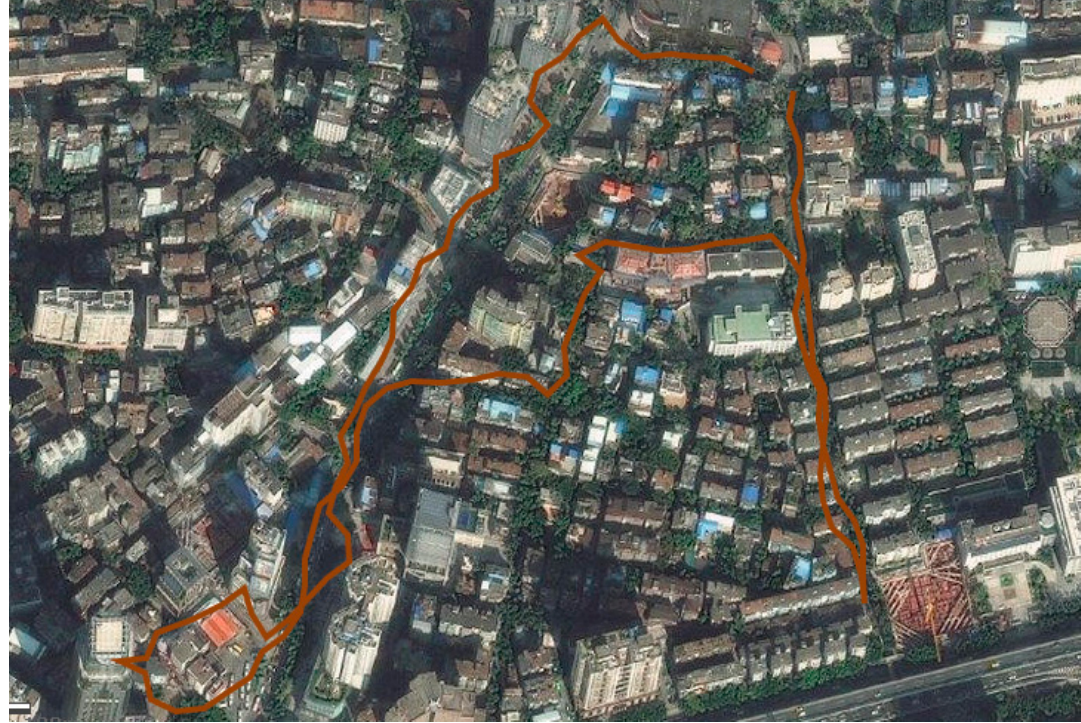
Figure 2. A part of the inspection route of the study site of Sanyu Road, Guangzhou City. The orange lines were inspection routes on an Android mobile device.